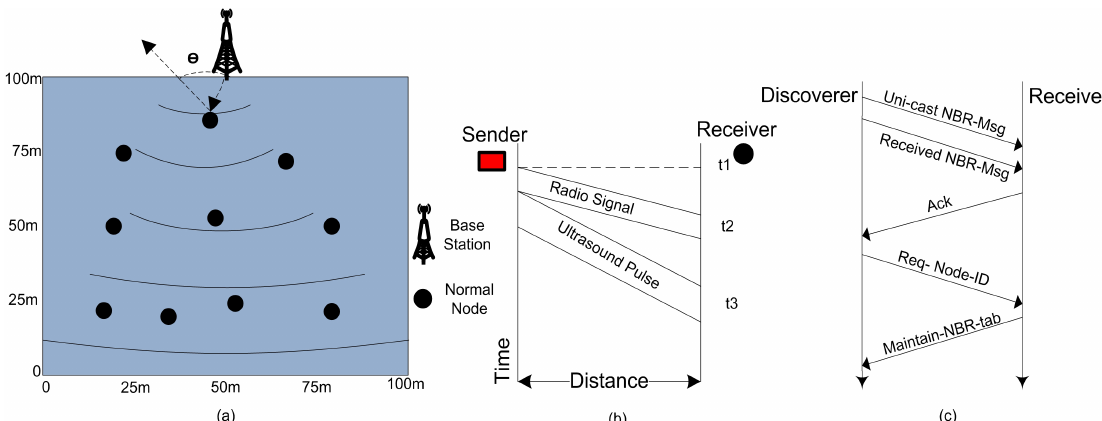
Figure 2. ( a ) The angle of signal arrival, ( b ) decrease in signal strength as it propagates from sender towards the receiver nodes, ( c ) neighbor discovery process.